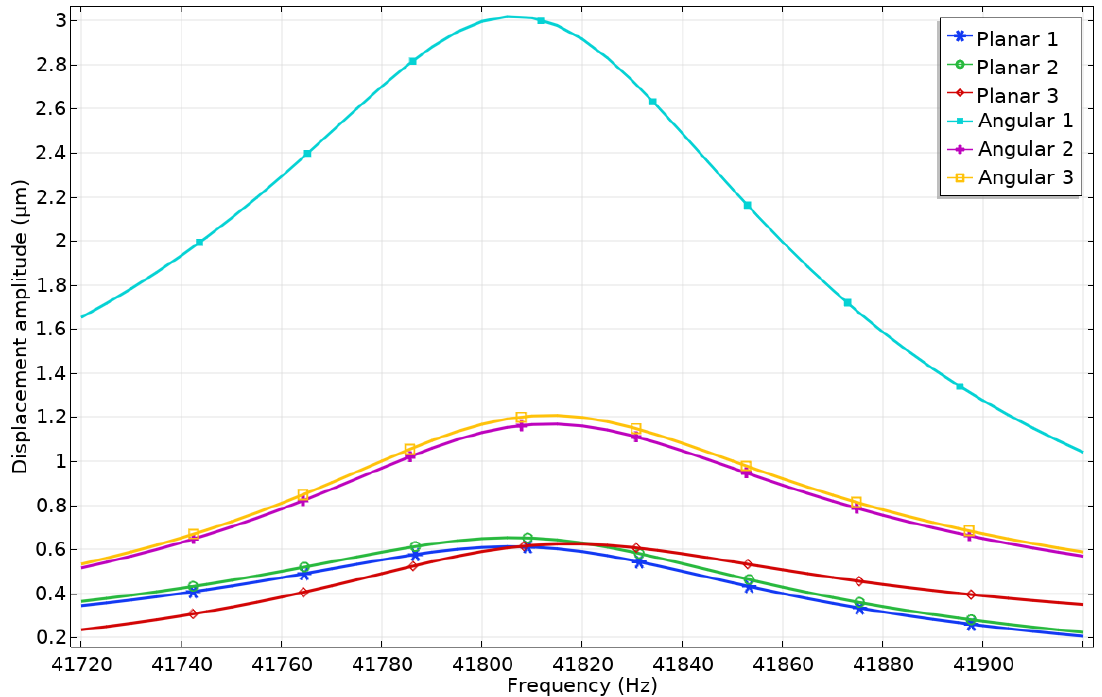
Figure 9. Displacement—frequency characteristics of the robot when the voltage of 100 V p-p is applied to electrode Angular 1.